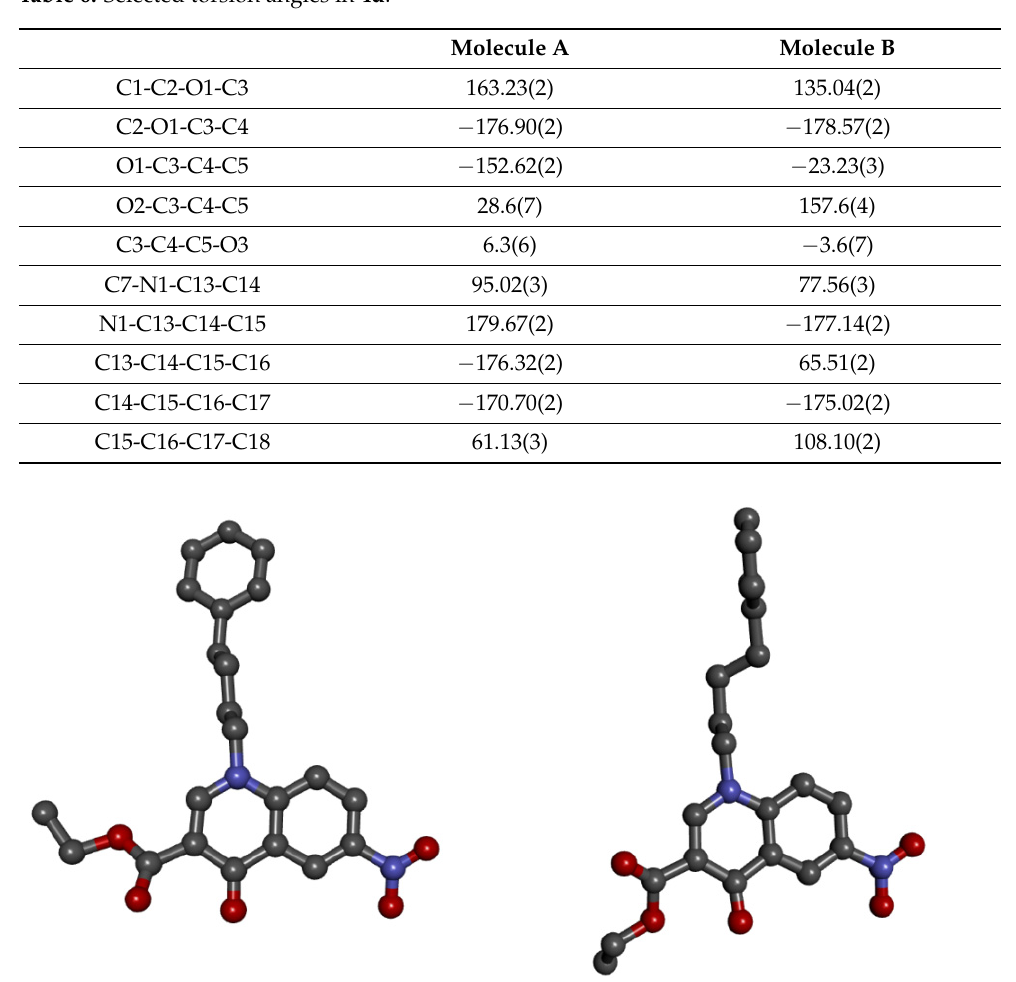
Figure 6. Ball-and-stick view of molecules A ( left ) and B ( right ).